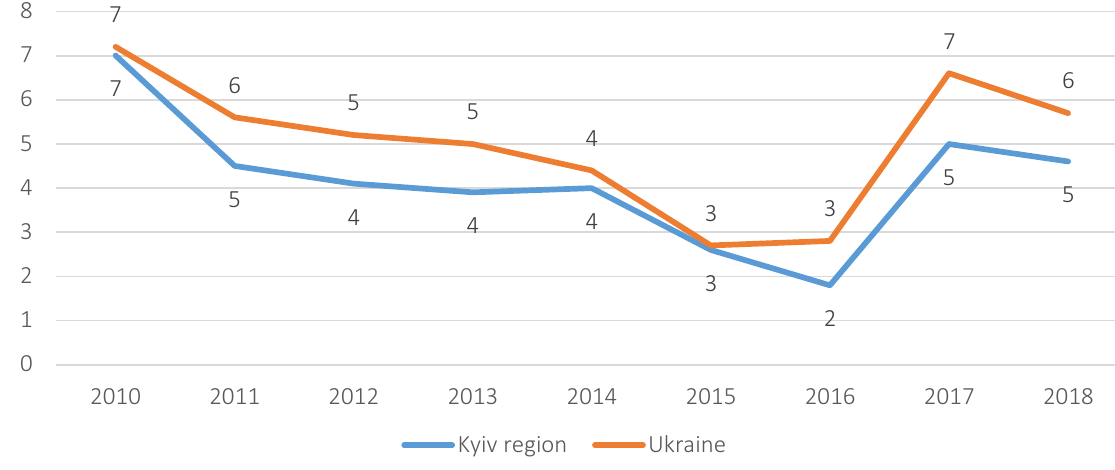
Figure 1. Dynamics of the employees who receive wages lower than the living wages (minimum wages) in the Kyiv region and in Ukraine in 2010–2018 (in